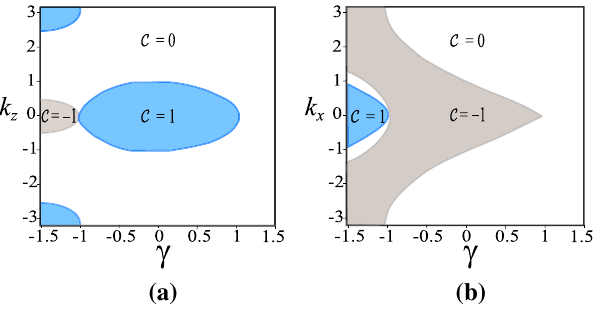
Figure 6. Phase diagrams and sector Chern number C . ( a ) C ( k z ) and ( b ) C ( k x ) where the blue area stands for C 1 and the gray one for C =